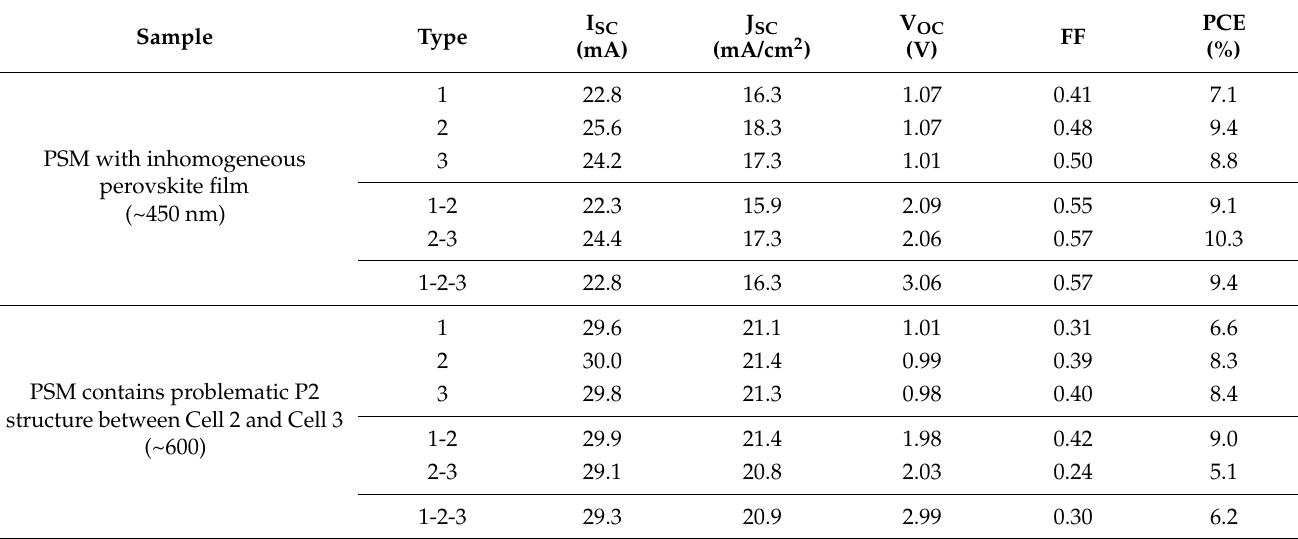
Table 3. Photovoltaic parameter of each single cell and interconnected